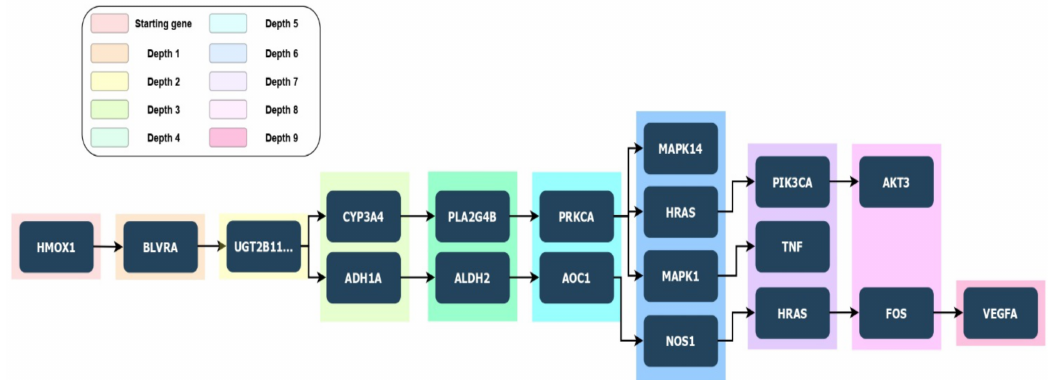
Figure 3. A schematic form of a depth tree coming from PETAL data results. It consists of a root node ( HMOX1 as starting gene) and subtrees connected to the root. Each subtree consists of several nodes (genes) leading to the target gene. The target genes detected by PETAL tool analysis are the following ones: (i) MAPK14 (depth 6), (ii) AKT3 (depth 8), (iii) TNF (depth 7), and iv) VEGFA (depth